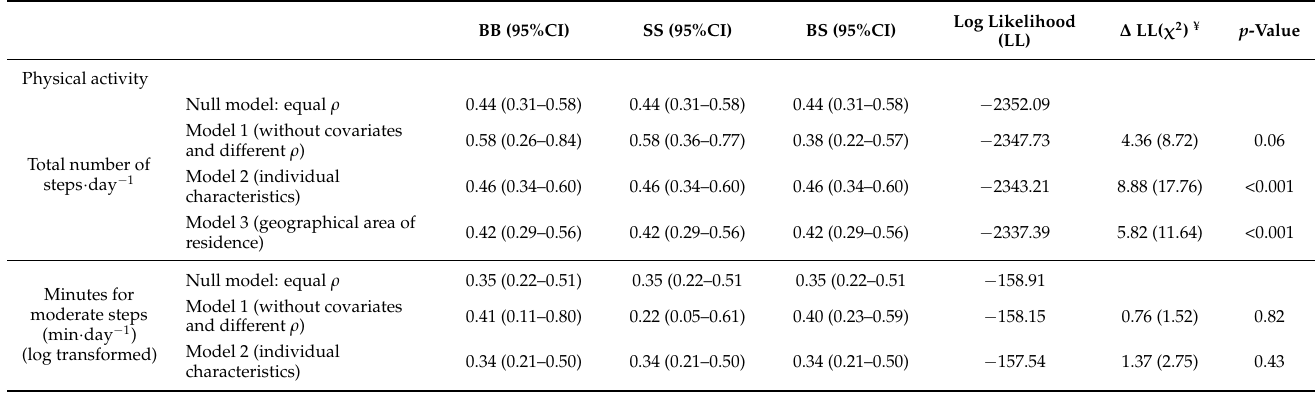
Table 2. Unadjusted and adjusted sibling’s correlations ( ρ ) and their 95% confidence intervals for both physical activity phenotypes.